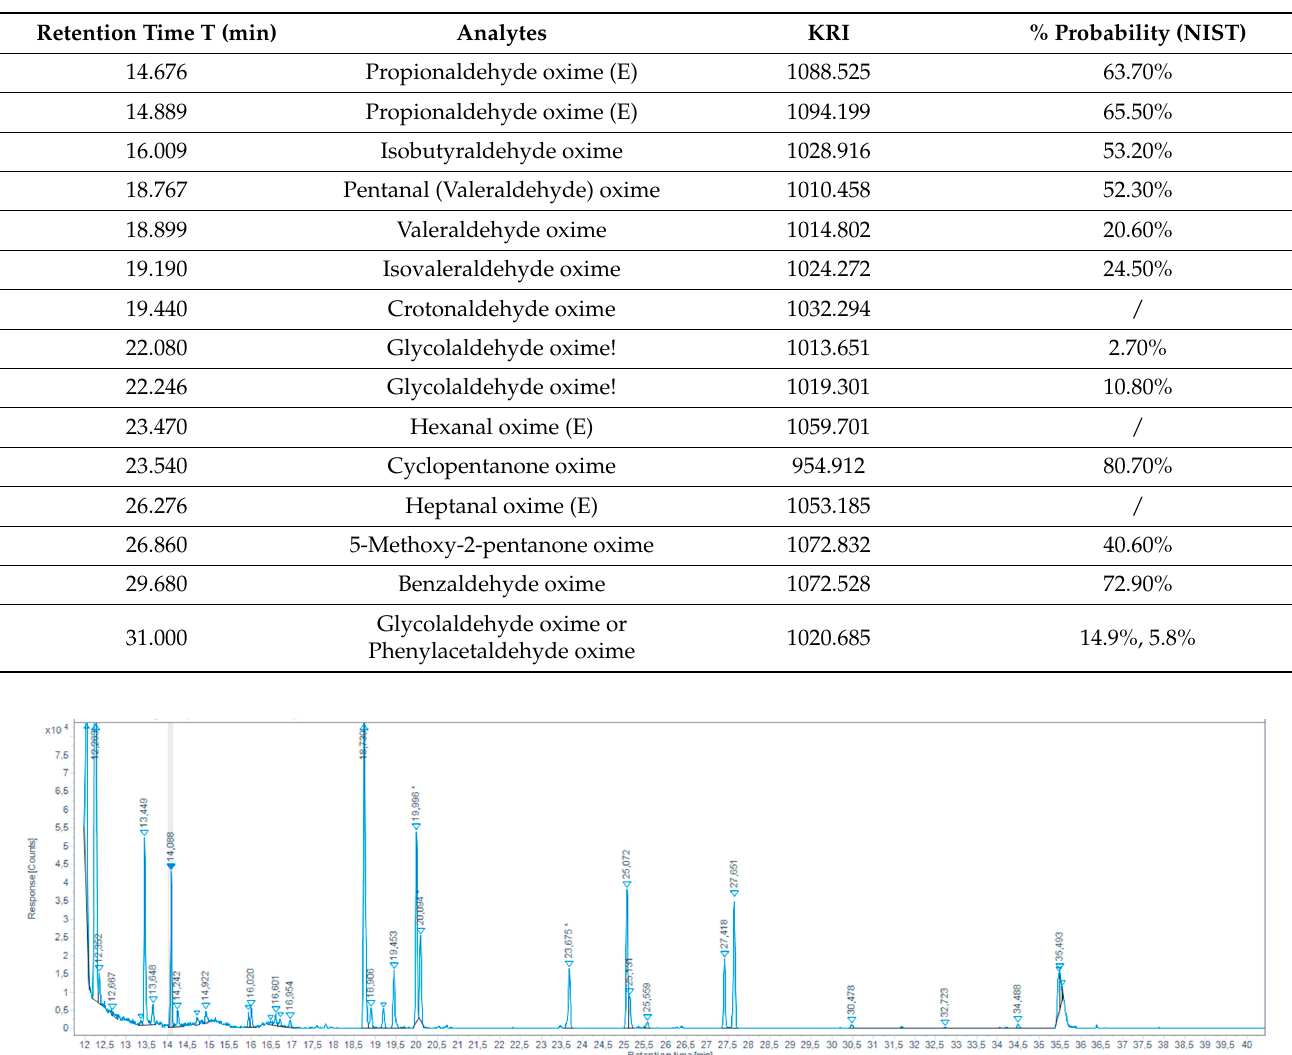
Table 5. Identification of carbonyl compounds in browned chicken meat juices extracted by HS-SDME on PFBHA droplet, based on RT, KRI, and fragmentation.